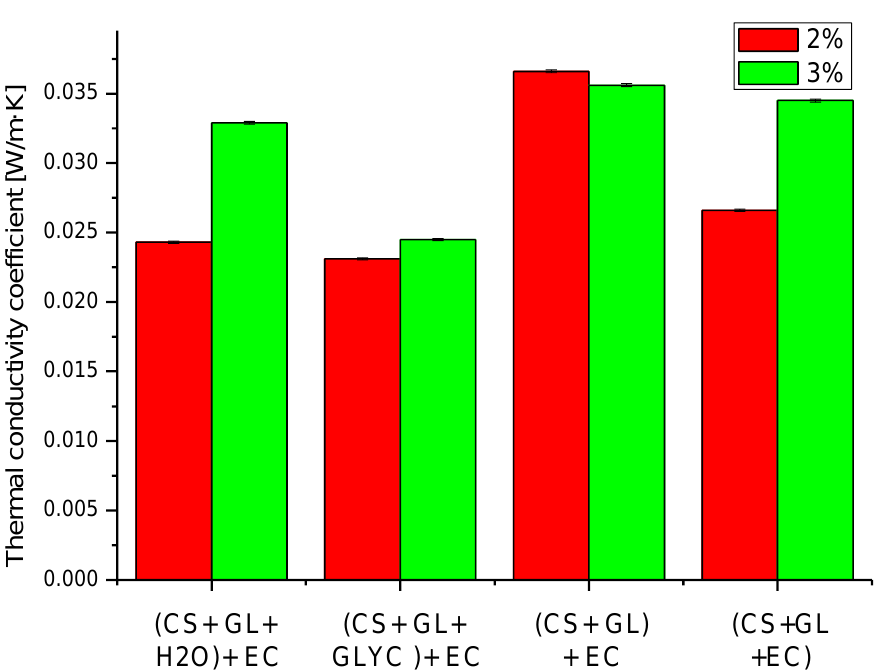
Figure 9. Thermal conductivity coefficients of obtained polyurethane foams (determined with ± 0.3%